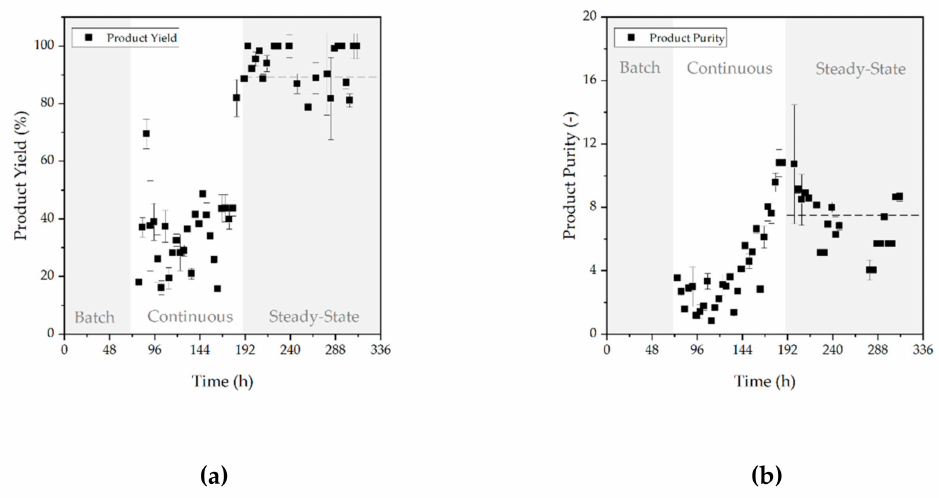
Figure 12. Yield ( a ) and purity ( b ) during batch, continuous, and continuous steady-state operation. The horizontal dashed line visualizes schematically the subsequent course of the steady-state phase after its initiation at 187 h. Error bars depict the double determination of each variable.